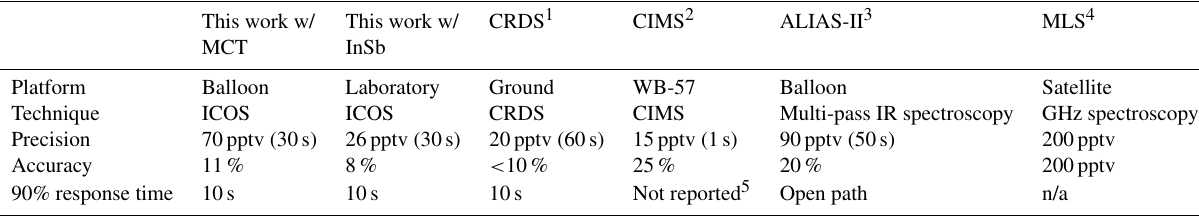
Table 1. Comparison of uncertainties among HCl instruments. “n/a” means not applicable. This work w/ This work w/ CRDS